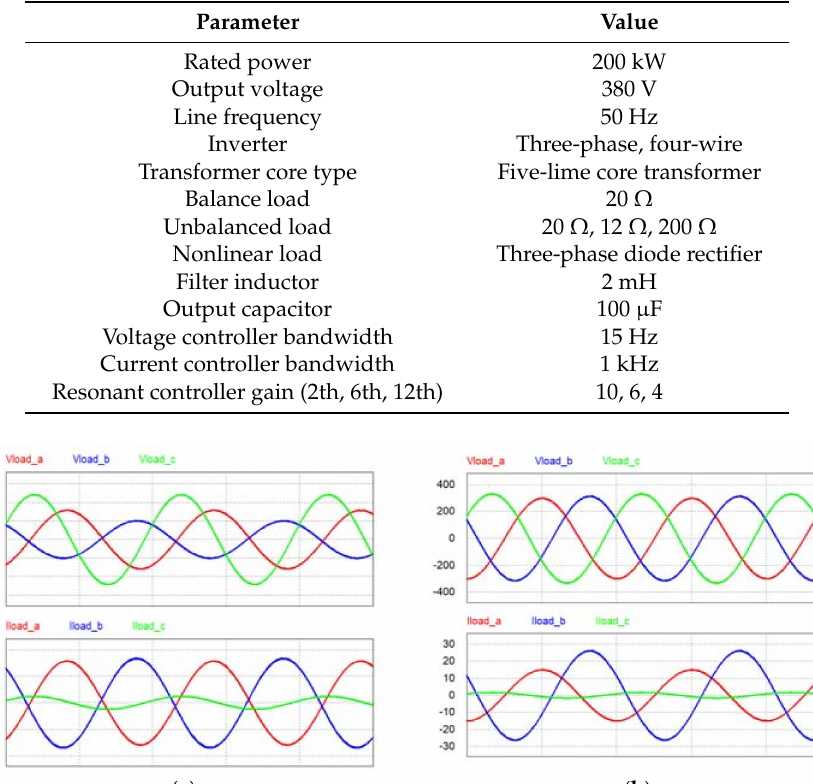
Table 1. System parameters.